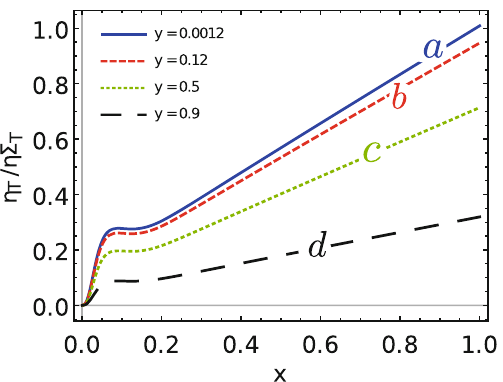
as function of x Fig. 7 Normalized Tolman–Whittaker Mass η T /η Σ T for n = 0 . 5 and different values of y (α) . (Blue) y (α) = 0.131649 (0.3). (Red) y (α) = 0.114082 (0.2). (Green) y (α) = 0.0871126 (0.1). Values of y are read off Fig. 4